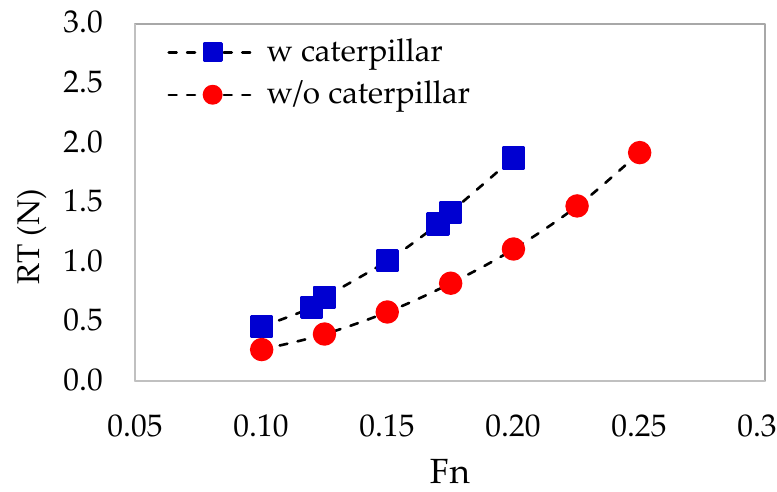
Figure 13. Result of load cell’s calibration.